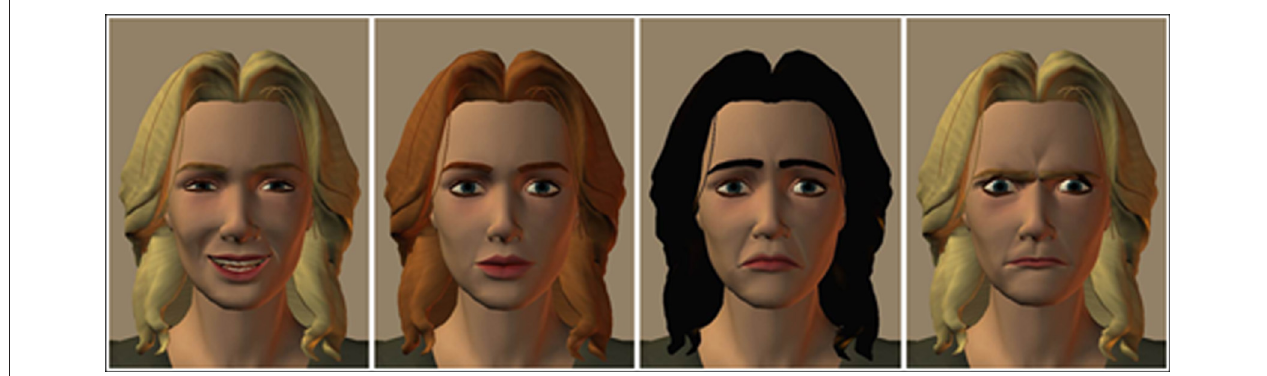
FIGURE 1 | Examples of avatars with different emotional facial expressions (happy, neutral, sad,